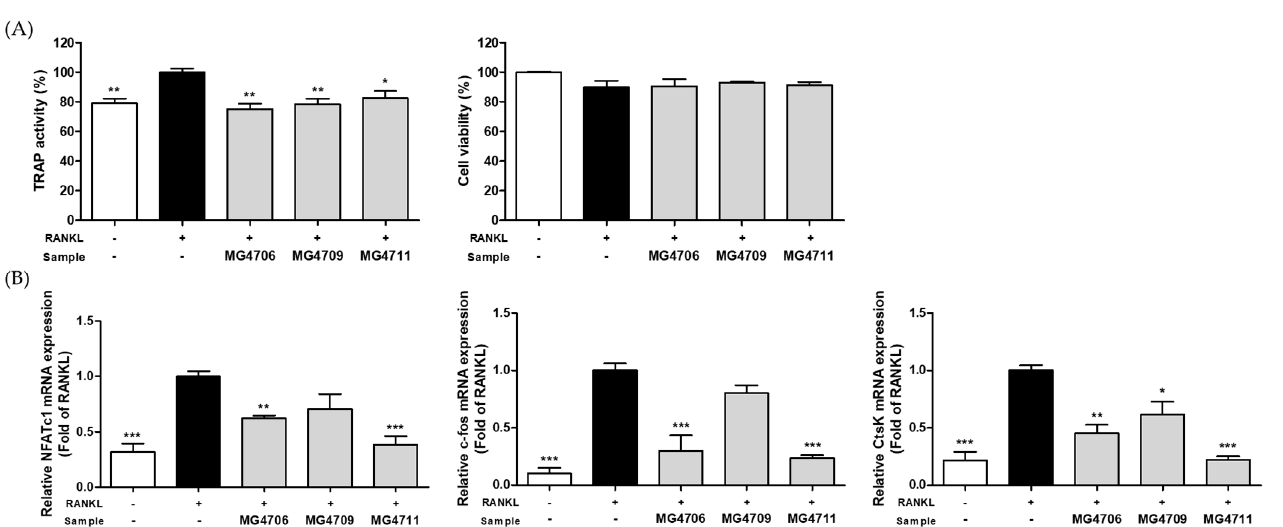
Figure 1. Effect of cell-free supernatant (CFS) from lactic acid bacteria (LAB) on ( A ) nitric oxide (NO) production, ( B ) inducible nitric oxide synthase ( iNOS ) mRNA expression, and ( C ) cytotoxicity in P. gingivalis LPS (PgLPS)-activated RAW264.7 cells. Data are represented as mean ± SEM ( n = 3). Sig- nificance was analyzed using Dunnett’s test. ** p < 0.01, *** p < 0.001 versus only treated-PgLPS group.